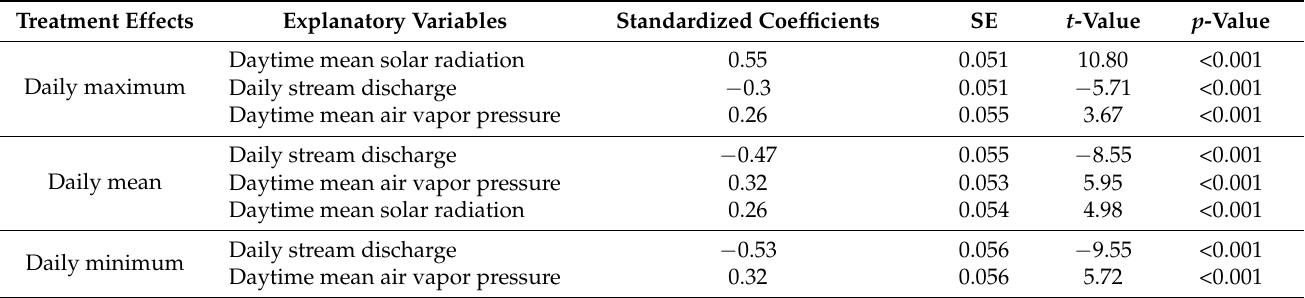
Table 5. Summary of multiple linear regression analysis with data from April to September